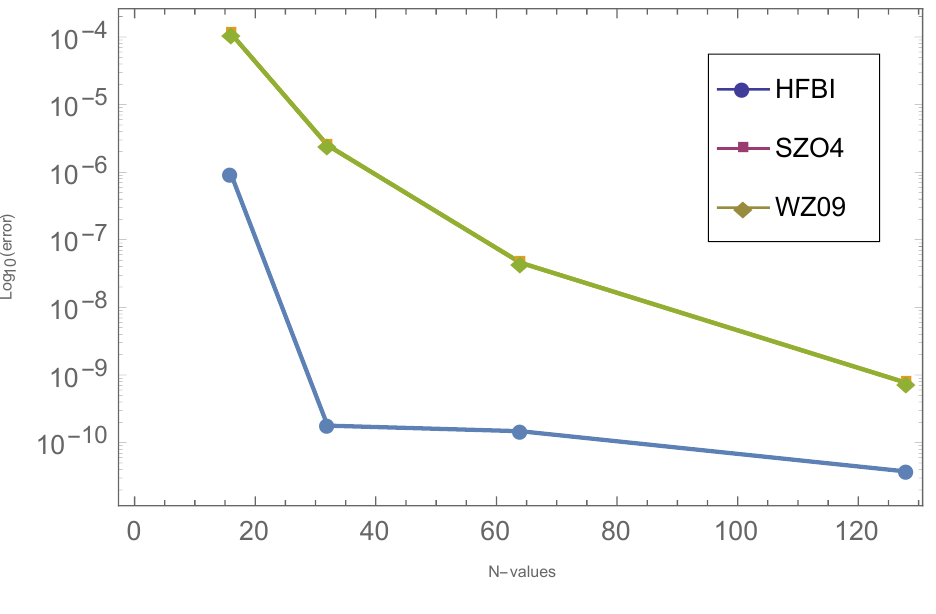
Figure 2. Efficiency curve for Problem 1. Table 2. Numerical results of exact-solution, computed-solution, and the Absolute error in HFBI for Problem